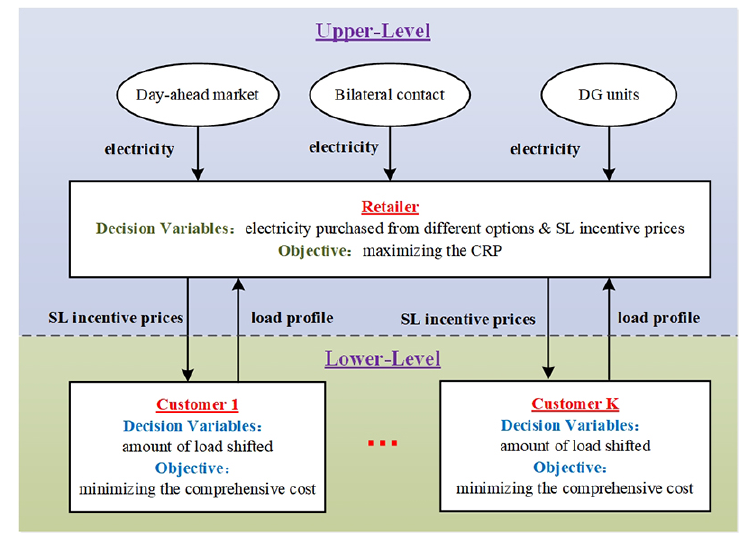
Figure 2. Framework of the bi-level